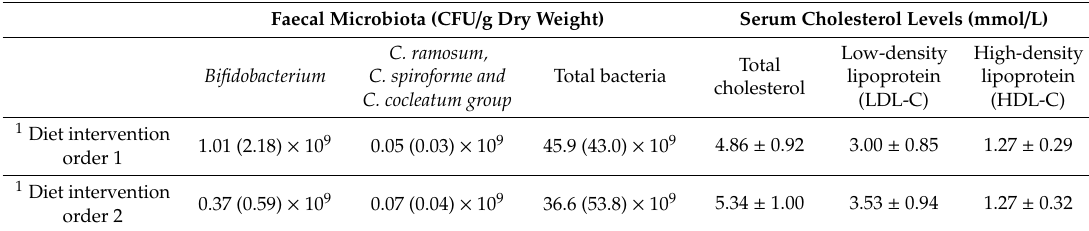
Table 1. Descriptive statistics of fecal microbiota and serum cholesterol levels reported as either median (interquartile range) or mean ± standard deviation.